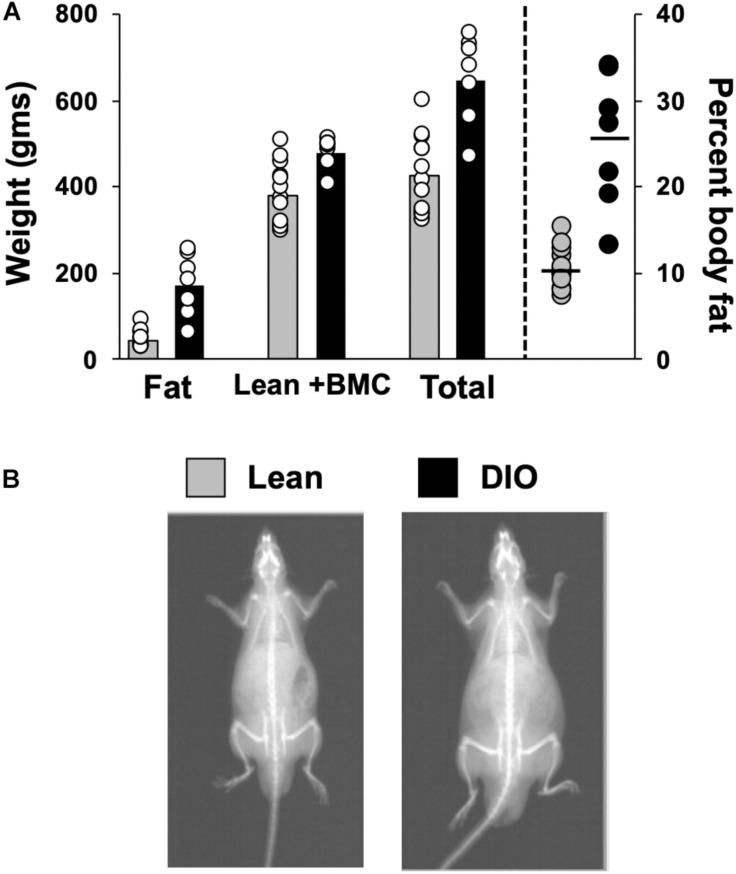
Body composition. (A) Scattergram of body composition data from lean and DIO rats. Left Y-axis: Animals’ fat mass in grams, lean plus bone mineral mass (BMC) content in grams, and total weight in grams. Right Y-axis: body fat percentage. Bars (left) and horizontal lines (right axis) indicate mean values and circles indicate values for individual rats. (B) DXA scan images of a lean (left) and obese (right) rat.